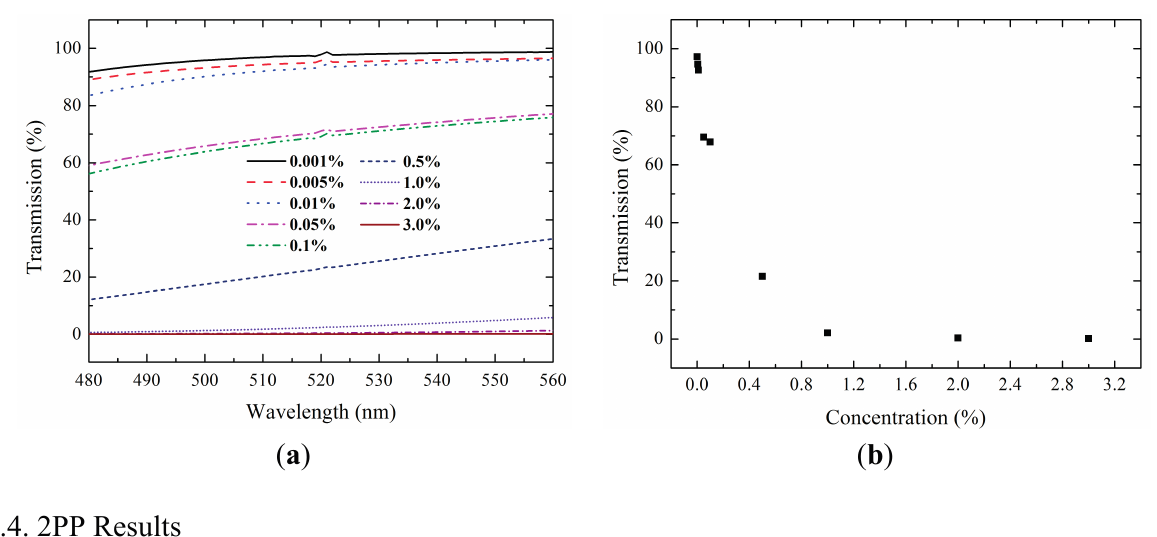
Figure 13. ( a ) Transmission spectra of various composite concentrations in the wavelength range of 480–560 nm; and ( b ) Transmission of composite concentrations at 2PP processing wavelength of 515 nm; Tip-sonication time for all samples was 8 min.